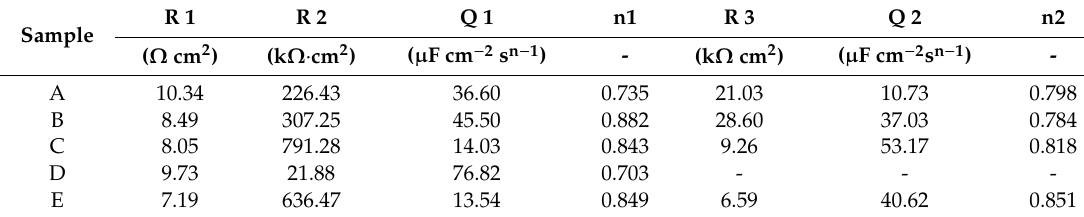
Table 8. EIS parameters in Ringer’s